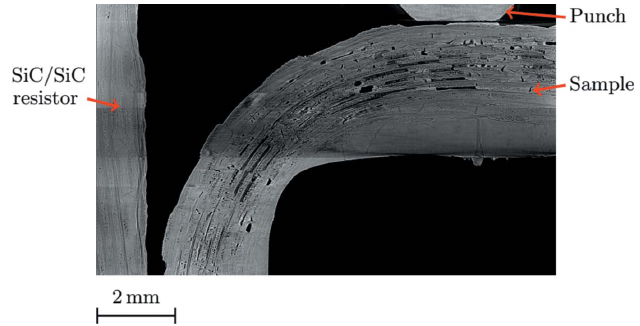
Figure 8 Tomograph of the sample where the beam hardening is noticeable: the part where the length crossed by the X-ray is higher appears darker.